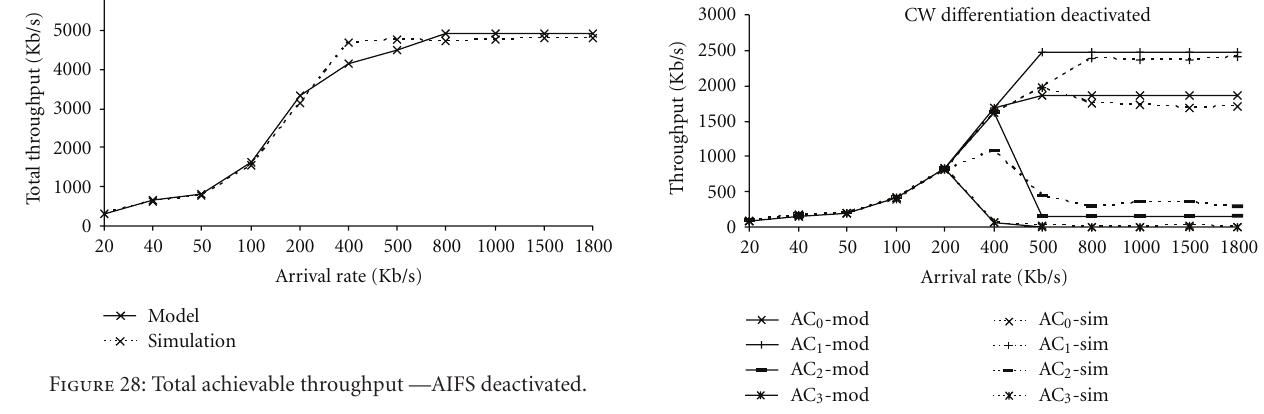
Figure 30: Achievable throughput per AC—CW deactivated.